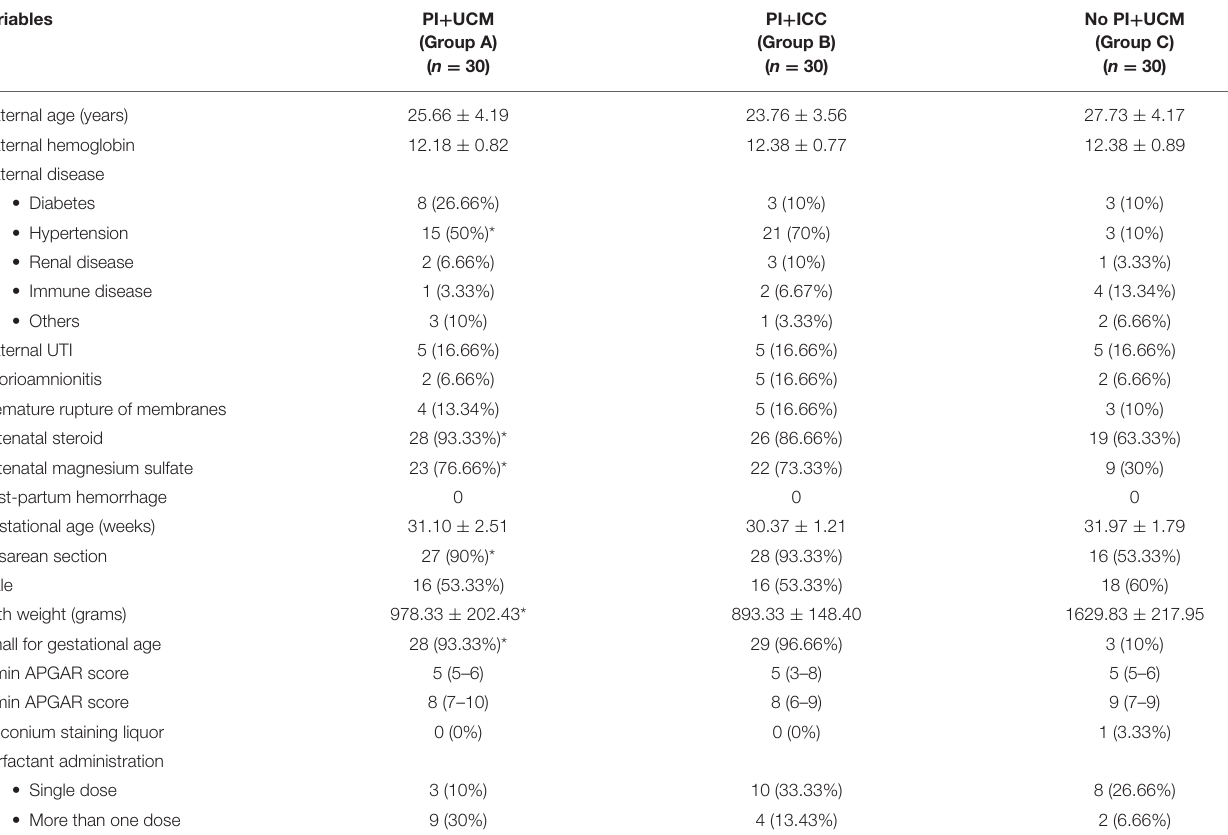
TABLE 1 | Demographic, prenatal, and baseline clinical characteristics.